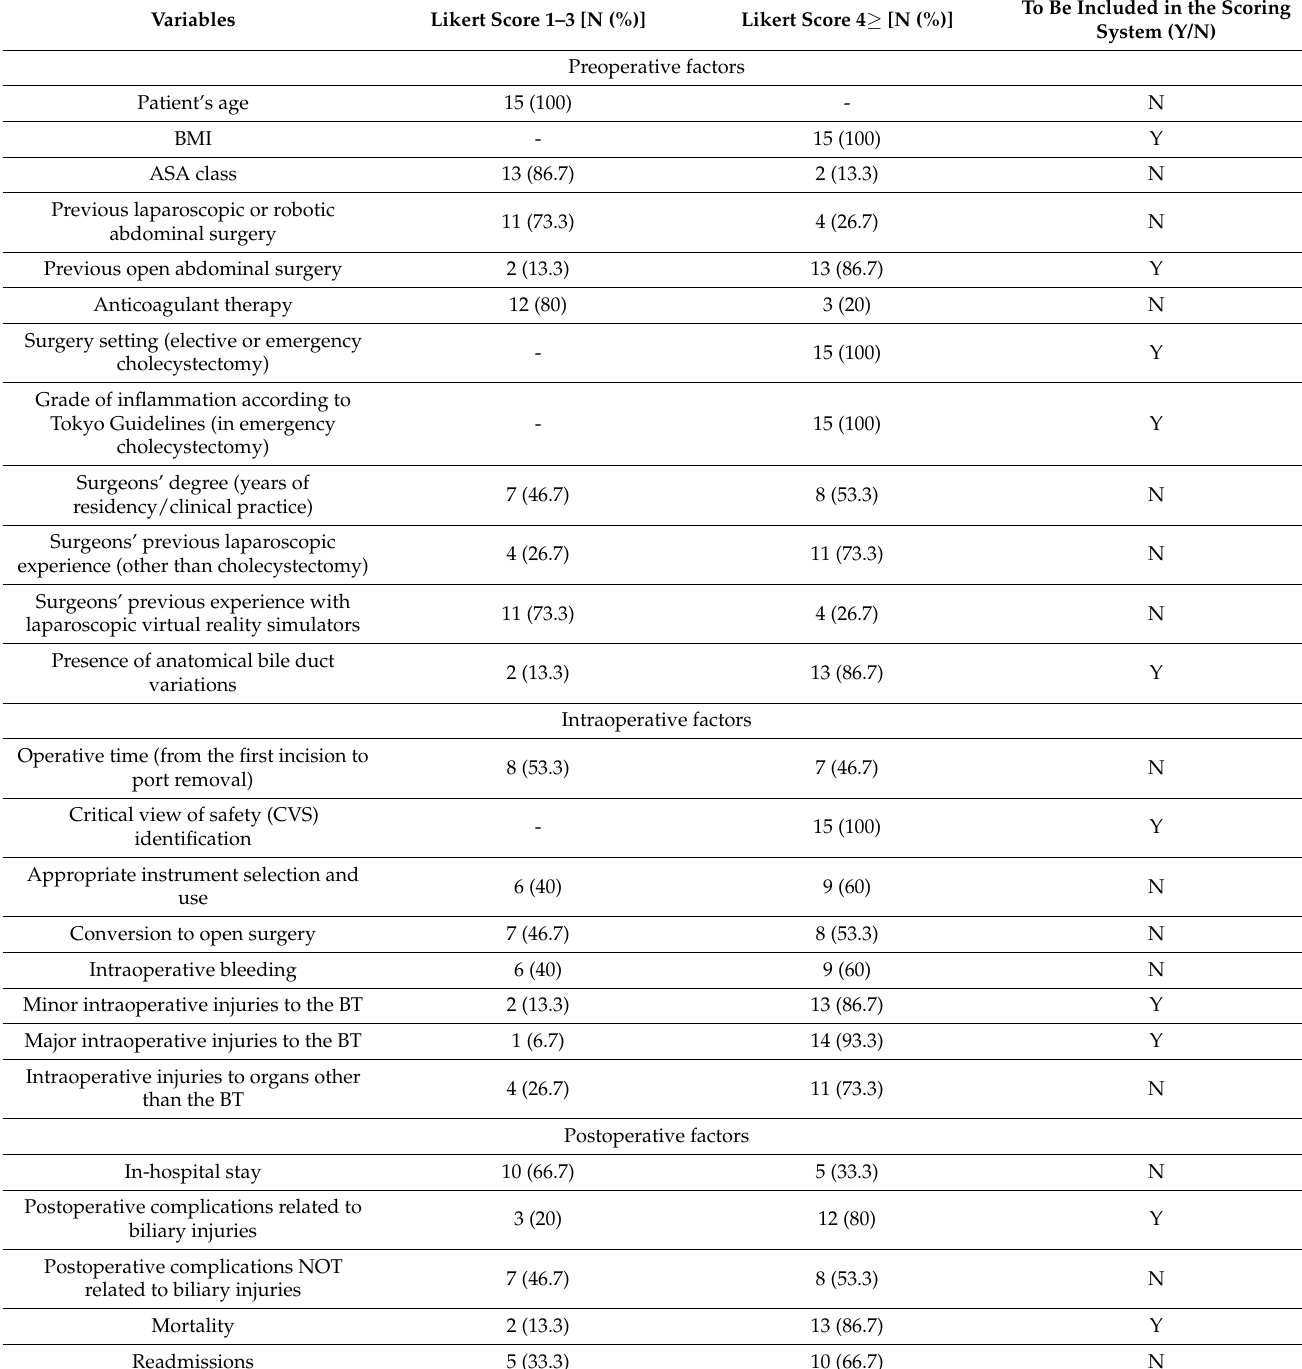
Table 2: BMI: body mass index; ASA: American Society of Anesthesiologists; CVS: critical view of safety; BT: biliary